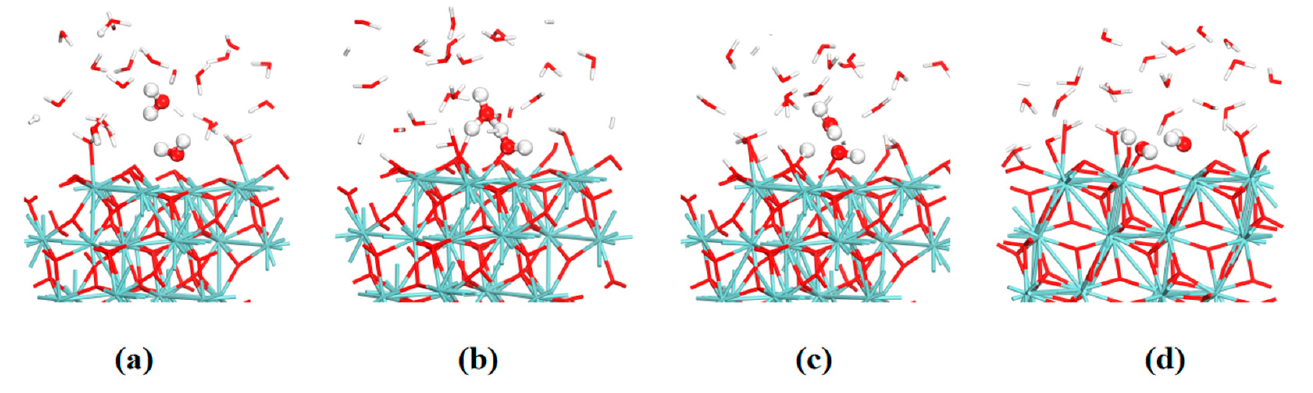
Figure 11. FPMD simulation snapshots at 0 ( a ), 500 ( b ), 1400 ( c ) and 2200 fs ( d ) of the water–solid interface reaction of ZrO 2 at site C .